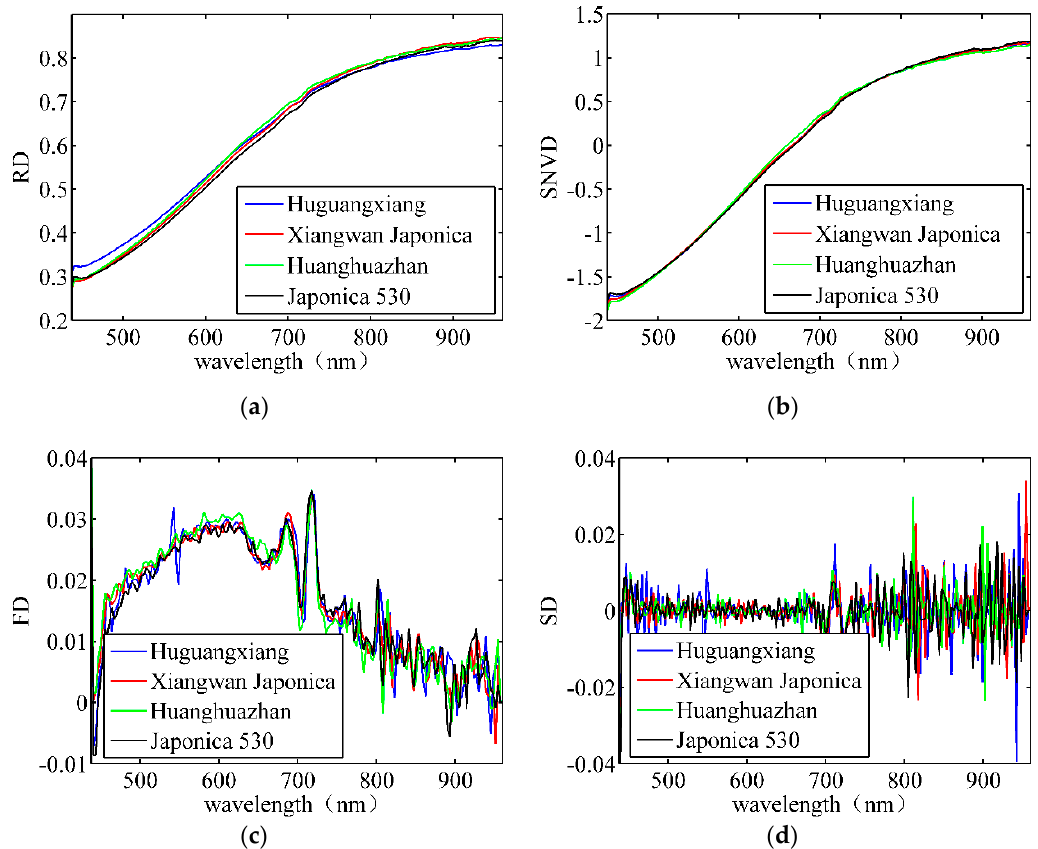
Figure 5. Average spectral features of four rice seeds. ( a ) Original reflectance spectrum; ( b ) spectrum after SNV; ( c ) spectrum after FD’ ( d ) spectrum after SD.